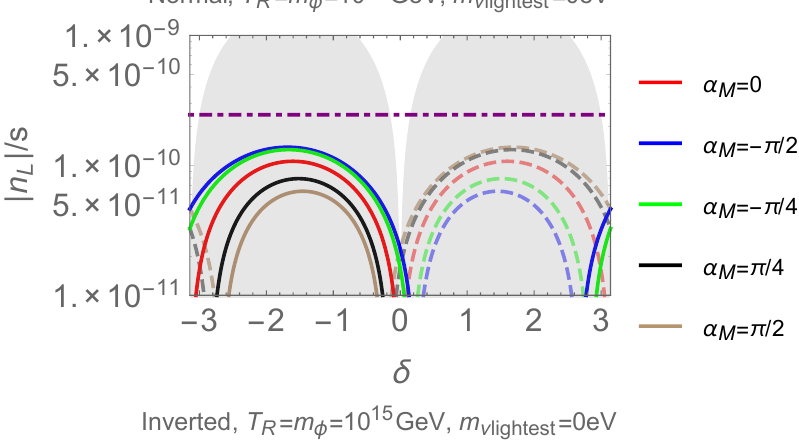
m m (cid:3) ( y 2 m m (cid:3) ) should appear in the (cid:23) 2 (cid:23) 1 (cid:28) (cid:28) (cid:23) 3 (cid:23) 2